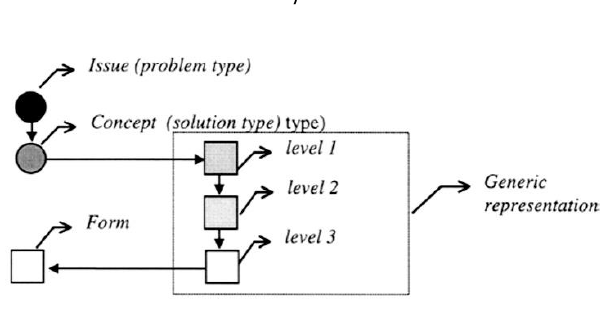
Figure 3. The steps of design thinking in generic or typological design (Oxman, 2001, p. 285)